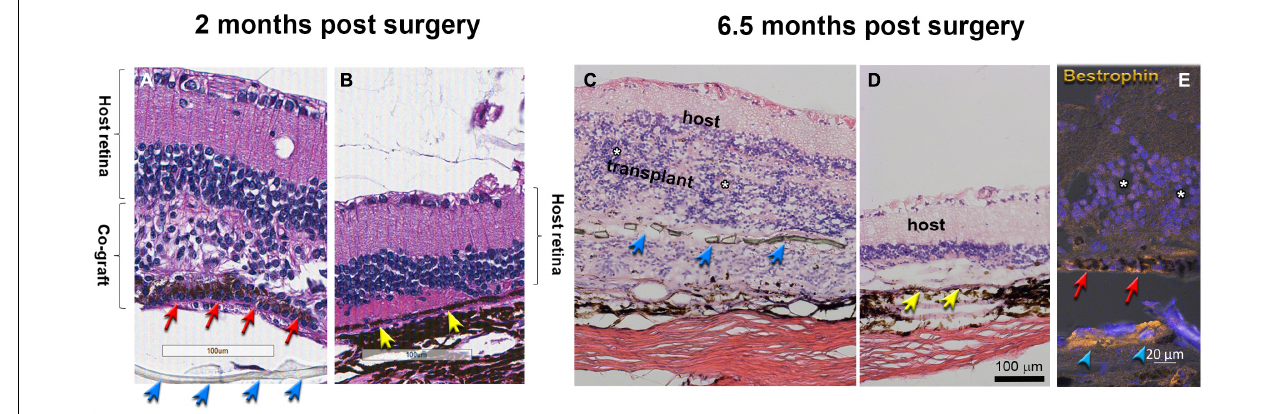
FIGURE 6 | Transplant histology at 2 months (A,B) and 6.5 months (C–E) post-surgery. (A,C) Co-graft area. (B,D) Host retina outside co-graft. (A–D) H&E staining. White asterisks indicate the center of rosettes (spherical arrangement of photoreceptors and other retinal layers around a central lumen). The transplant in (C) has grown around the parylene RPE implant (transplant #3 in Table 3 , 197 dps). (E) Bestrophin (gold) and DAPI (blue) shows RPE and parylene in transplant (#2 in Table 3 , 195 dps). Blue arrows point to parylene. Red arrows point to hESC-RPE. Yellow arrows point to host RPE. The separation of tissue is processing artifact. Scale bars = 100 µ m (A–D) ; 20 µ m (E)